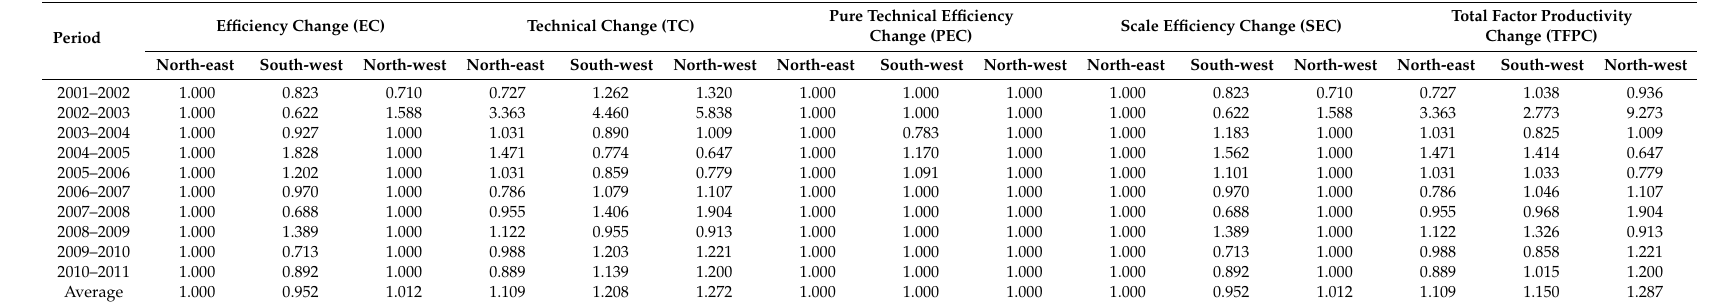
Table 4. TFP of state-owned enterprises in three regions from 2001 to